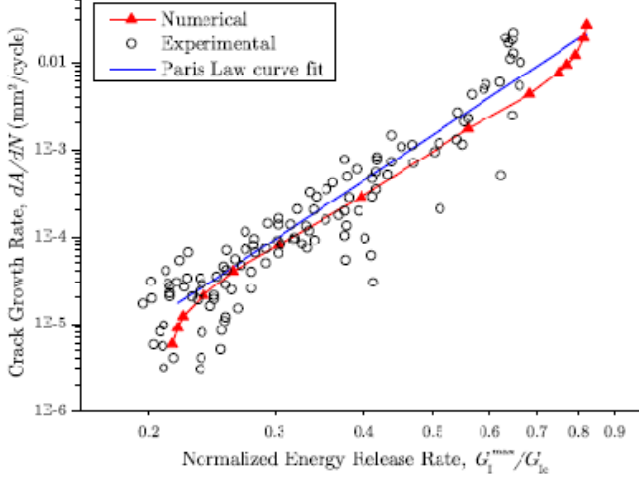
Figura 8: Confronto tra risultati sperimentali e previsione del modello da [12].